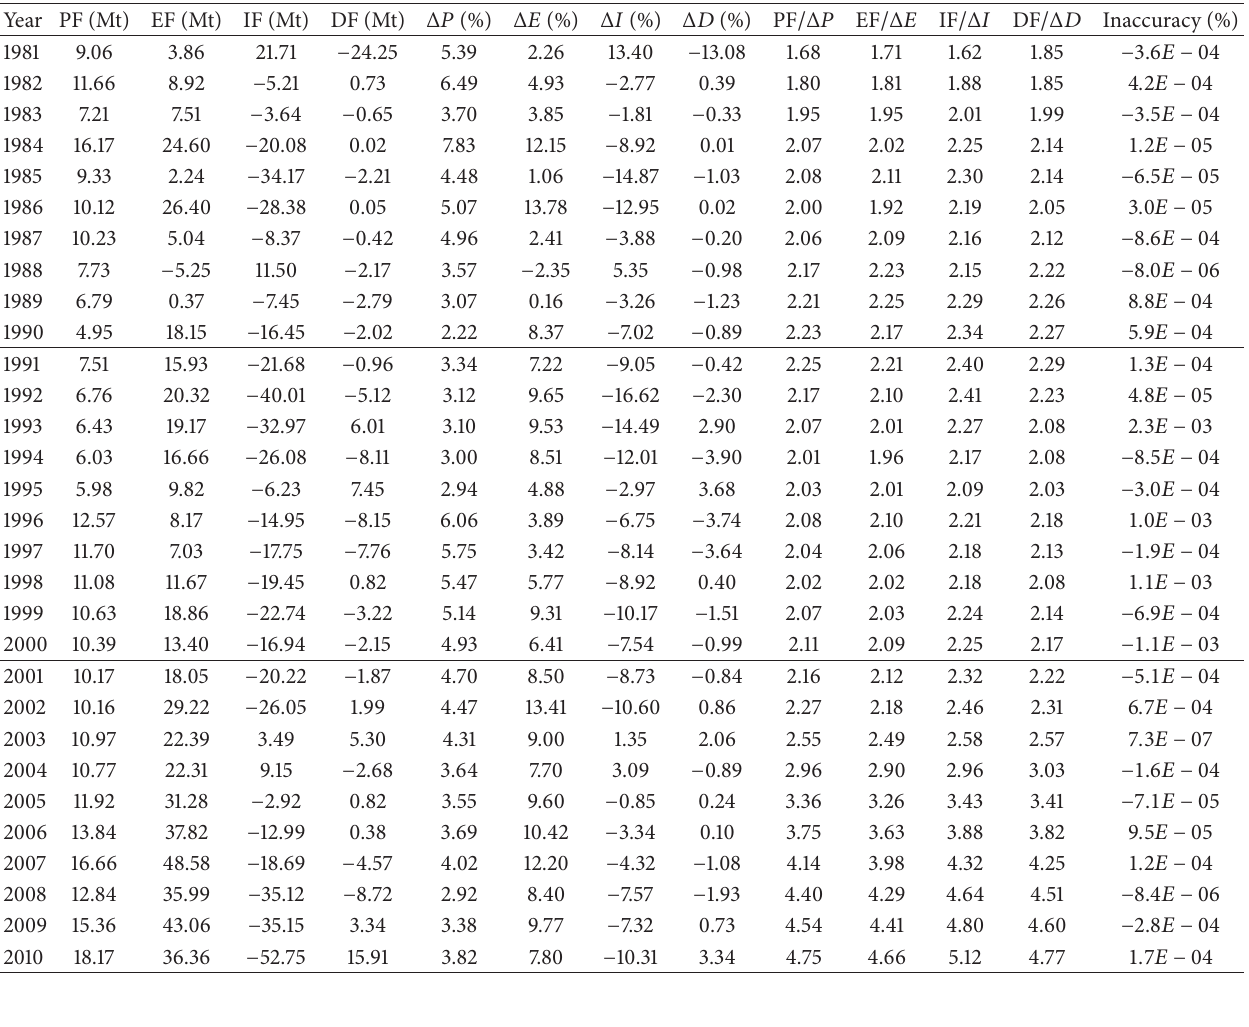
emissions (1981–2010). 2